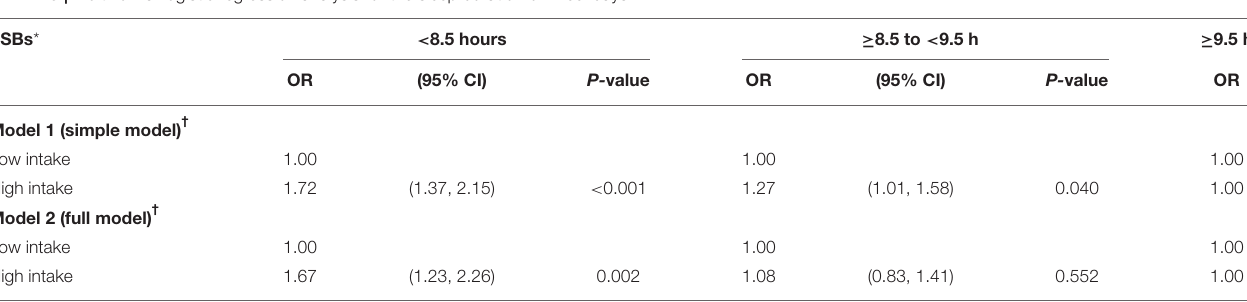
TABLE 3 | Multinomial logistic regression analysis for the sleep duration on weekdays. SSBs